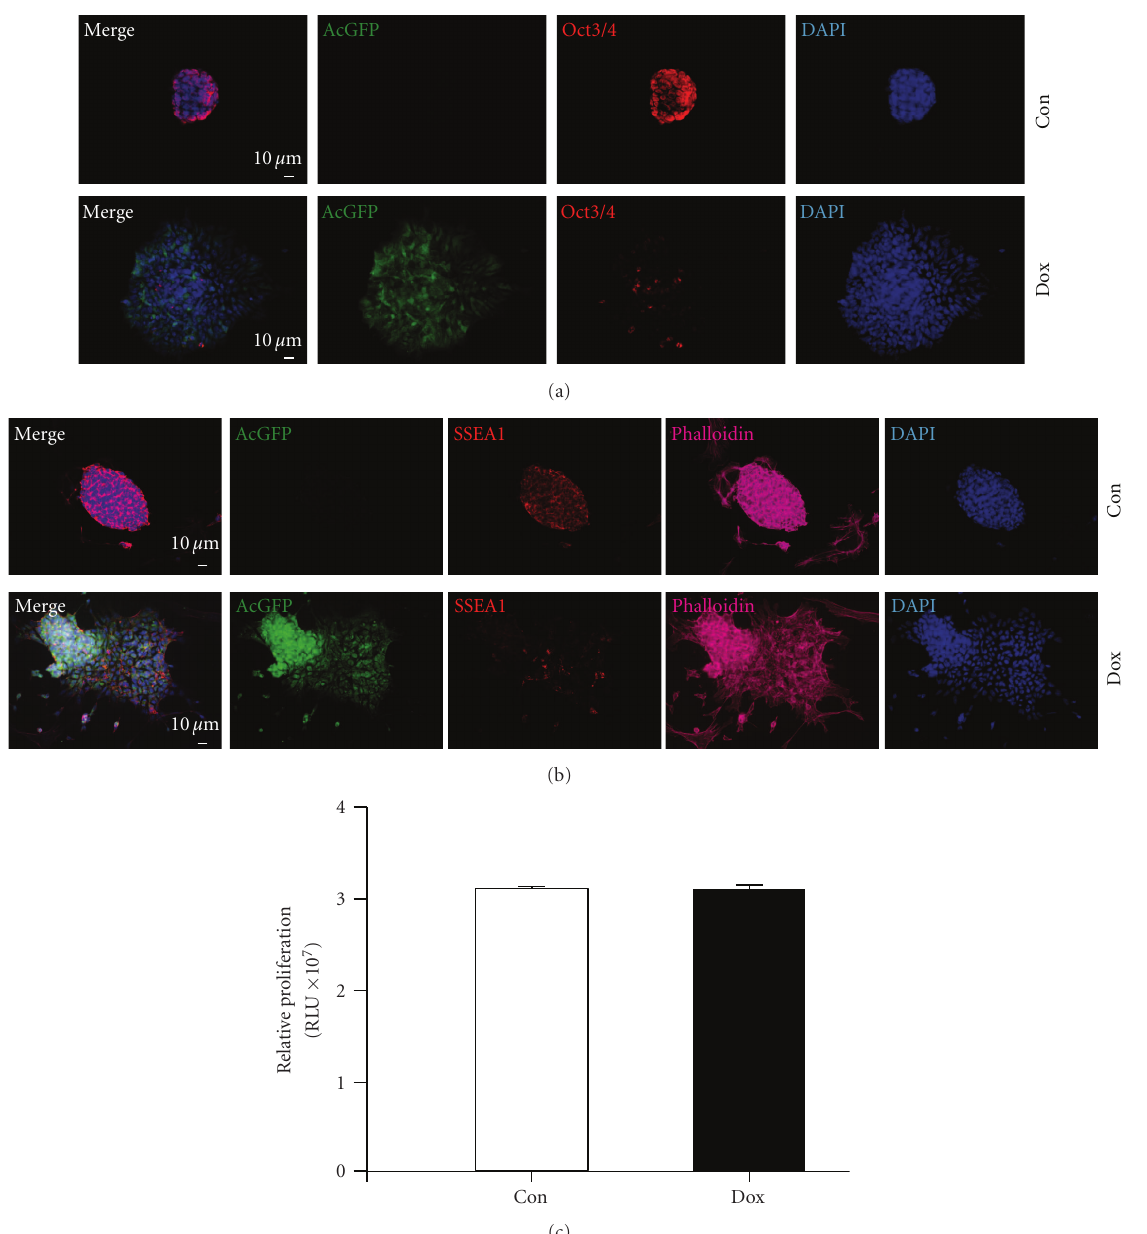
Figure 4: Doxycycline treatment alters cell behavior. (a) Elongated dox treatment for 3 days alters the pluripotency and morphology of the ES cells. Oct3/4 proteins (red) are decreased, and green fluorescence is solely expressed by dox-treated cells. (b) In line, the ES cell marker SSEA1 is lost during dox treatment (red), and the actin cytoskeleton, visualized by the f-actin marker phalloidin, is altered upon dox treatment. (c) Proliferation of iSK4 cells is not changed by dox-treatment shown in a proliferation assay. ( n = 4) for all experiments. Nuclei are stained by DAPI (blue). Scale bars as